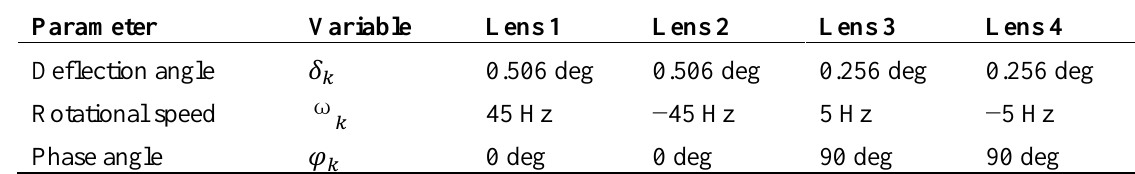
Table 3. Parameters of the scanning mechanism (related to Equation